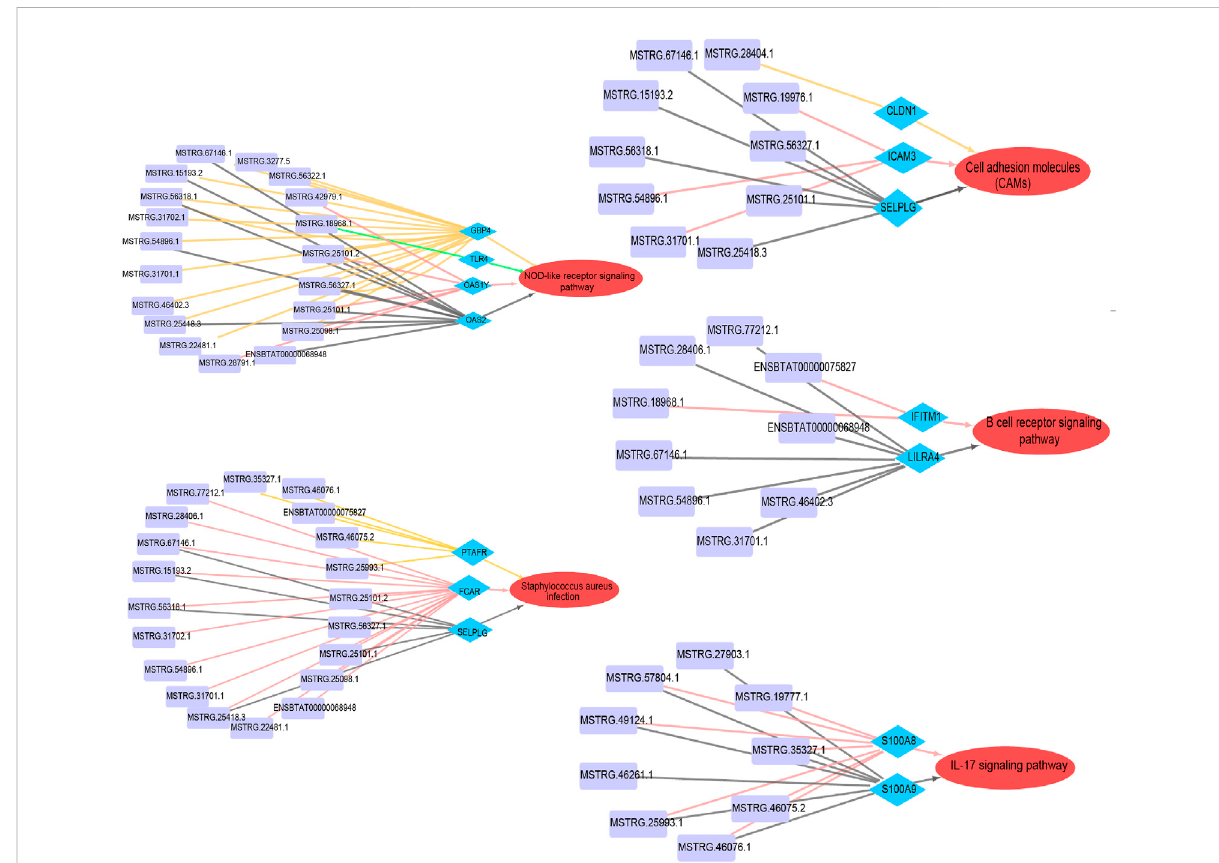
FIGURE 6 Co-expression networks of lncRNAs cis - and trans - target gene pathways; In particular, these fi ve pathways were shared by differentially expressedgenes (DEGs) and differentiallyexpressedlncRNAs (DELs), includingthe NOD-like receptor, S. aureus infection,and cell adhesion (CAMs), B-cell receptor, and IL-17 signaling pathways. Purple rectangles represents DELs, blue diamonds represents DEGs, red ellipses represents critical paths, and different target relationships in the same regulatory network are distinguished by different colored